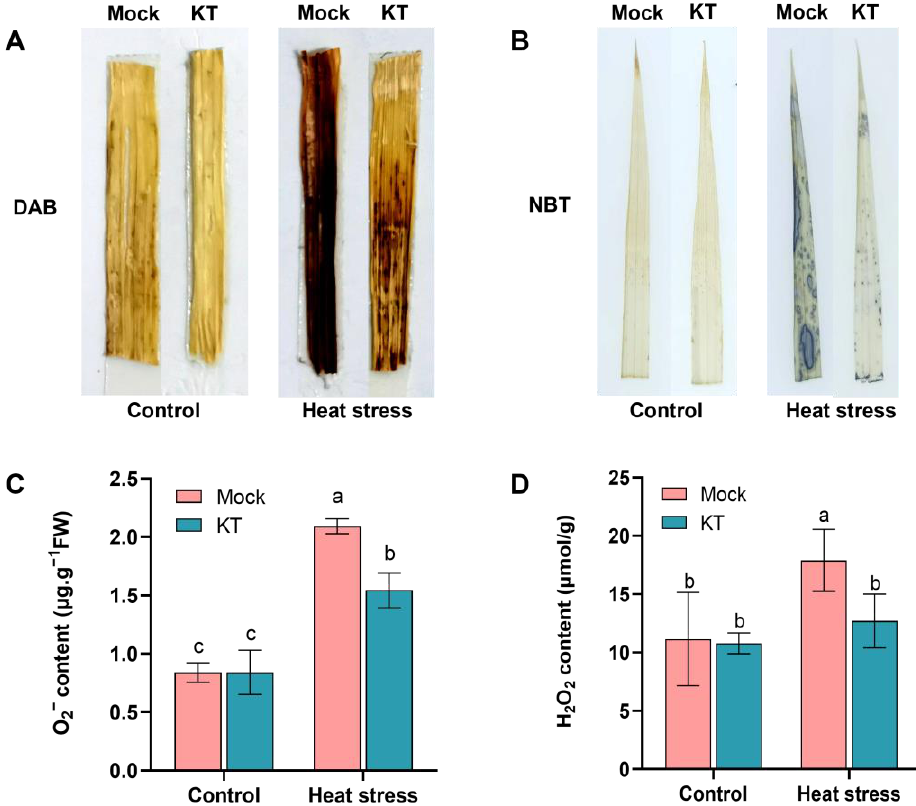
Figure 3. Effect of exogenous KT treatment on ROS levels in seedlings under heat stress. NBT staining ( A ), DAB staining ( B ), O 2 − content ( C ), and H 2 O 2 content ( D ) test of 10 − 9 M KT versus mock seedlings under heat stress. Data are means ± SD. Different lowercase letters show significant differences among treatments analyzed by one-way ANOVA comparison test (n = 3, p < 0.05).